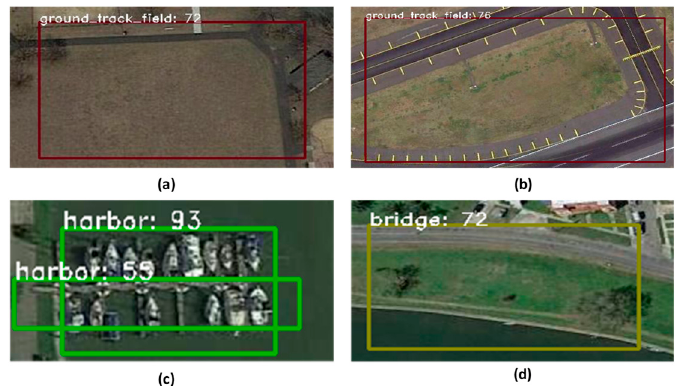
Figure 17. Some typical bounding boxes belonging to background that are falsely detected as objects in the CACMOD CNN framework. (a) ground track field. (b) ground track field. (c) harbor. (d) bridge. the CACMOD CNN framework. ( a ) ground track field. ( b ) ground track field. ( c ) harbor. ( d ) bridge.